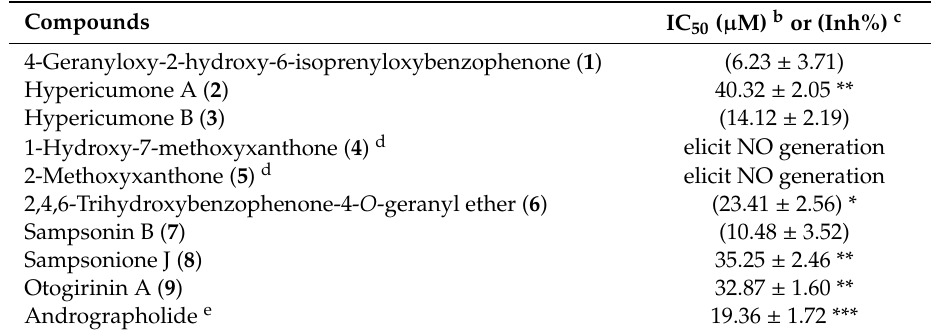
Table 1. Inhibitory e ff ects of Compounds 1 – 9 from the aerial parts of H. sampsonii on nitric oxide (NO) generation by RAW264.7 murine macrophages in response to lipopolysaccharide (LPS) a .